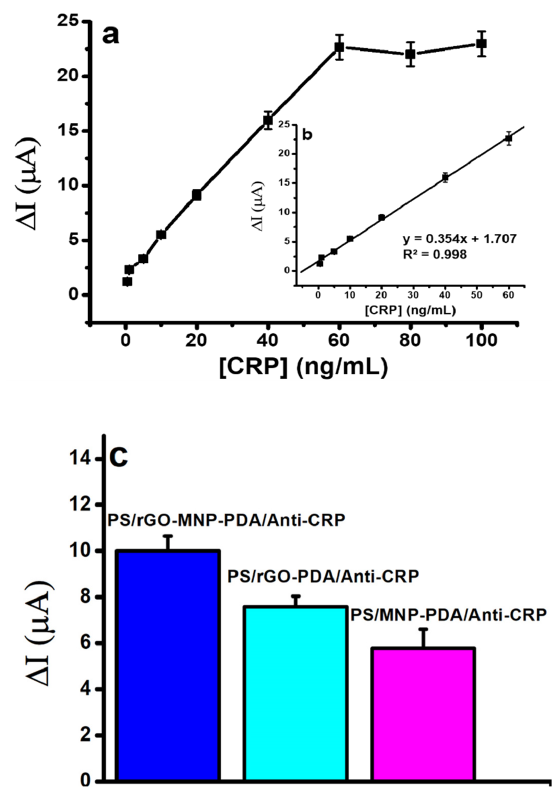
Figure 5. ( a ) Impact of CRP concentration on the immunosensor current response, ( b ) Linear detection range of CRP, ( c ) CRP detection with PS/rGO-MNP-PDA/Anti-CRP, PS/rGO-PDA/Anti-CRP, and PS/MNP-PDA/Anti-CRP immunosensors. (All measurements, scan rate: 50 mVs − 1 , in the presence of 10 mL PBS (pH 7.4) solution including 5 mM HCF and 0.1 M KCl, [CRP] = 20 ng/mL. Error bars show the standard deviation of at least 3 replicate measurements).